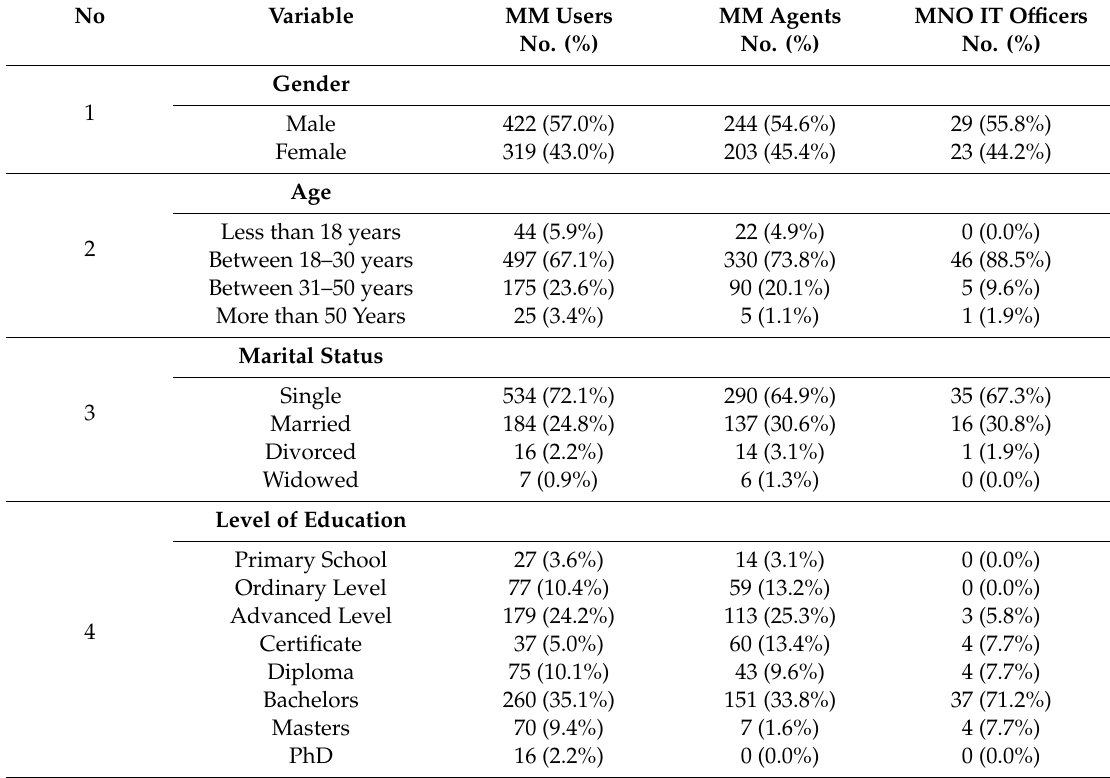
Table 1. Respondents’ social demography characteristic i.e., gender, age, marital status, and level of